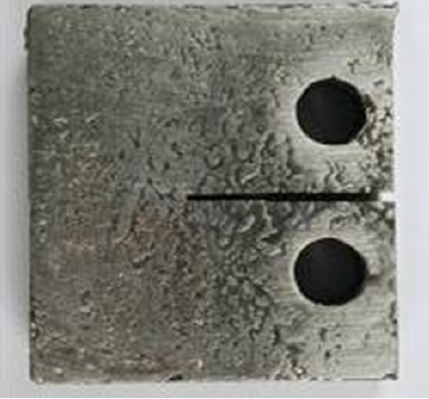
Figure 1: Macrograph showing the CT